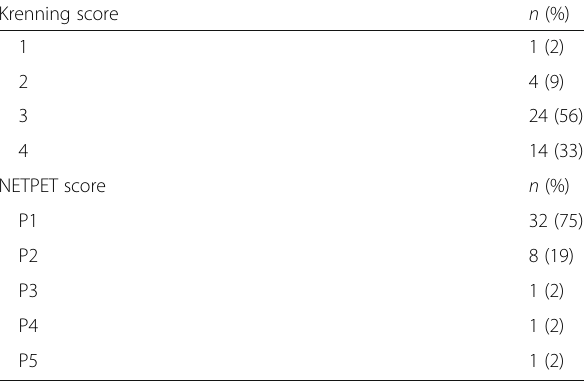
Table 2 Krenning and NETPET score of the lesions ( n = 43)